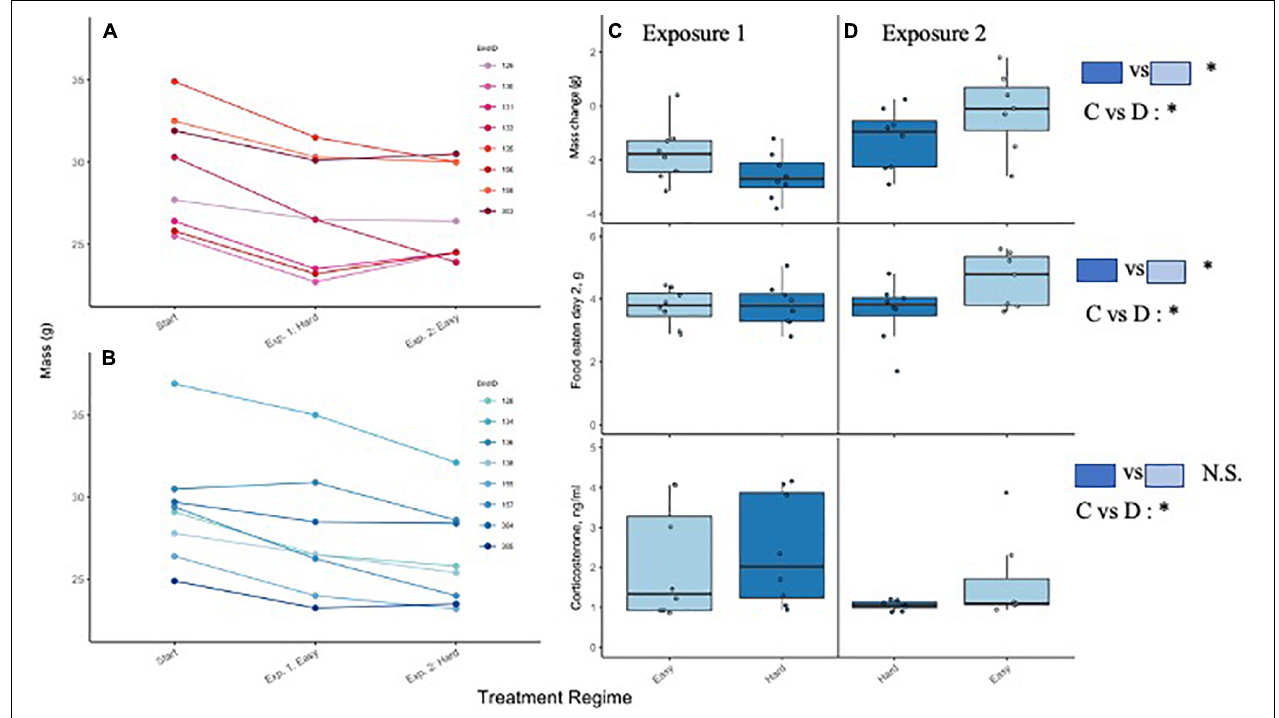
FIGURE 7 | Left hand panels. Pattern of body mass change for each bird throughout the study. Panel (A) shows birds that received the easy workload regime during the first exposure, followed by the hard regime; panel (B) shows birds that received the reverse treatment order. Right hand panels. Change in body mass during trial was affected by workload treatment and 1st vs. 2nd exposure to treatment. Change in body mass during trial was affected by workload treatment regime ( C,D top) and treatment order ( C,D middle and bottom). Shading reflects treatment number, with treatments separated into (C,D) . Lower right hand panel. Baseline corticosterone (ng/mL) was not significantly influenced by workload (feeding regime) but was elevated during the first exposure regardless of regime. Most birds lost weight under all